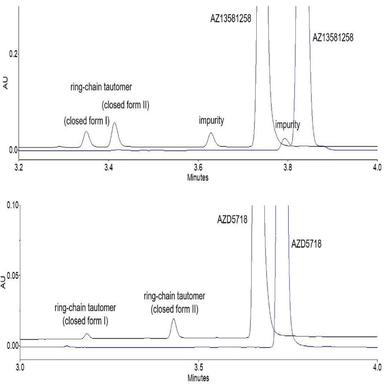
AZ13581258 and AZD5718, respectively, showing separation between three peaks with the same m/z in acid chromatographic conditions, i.e. main peak and ring-chain tautomer (black UV chromatograms), while no additional peaks were detected in basic chromatographic conditions (blue UV chromatograms).